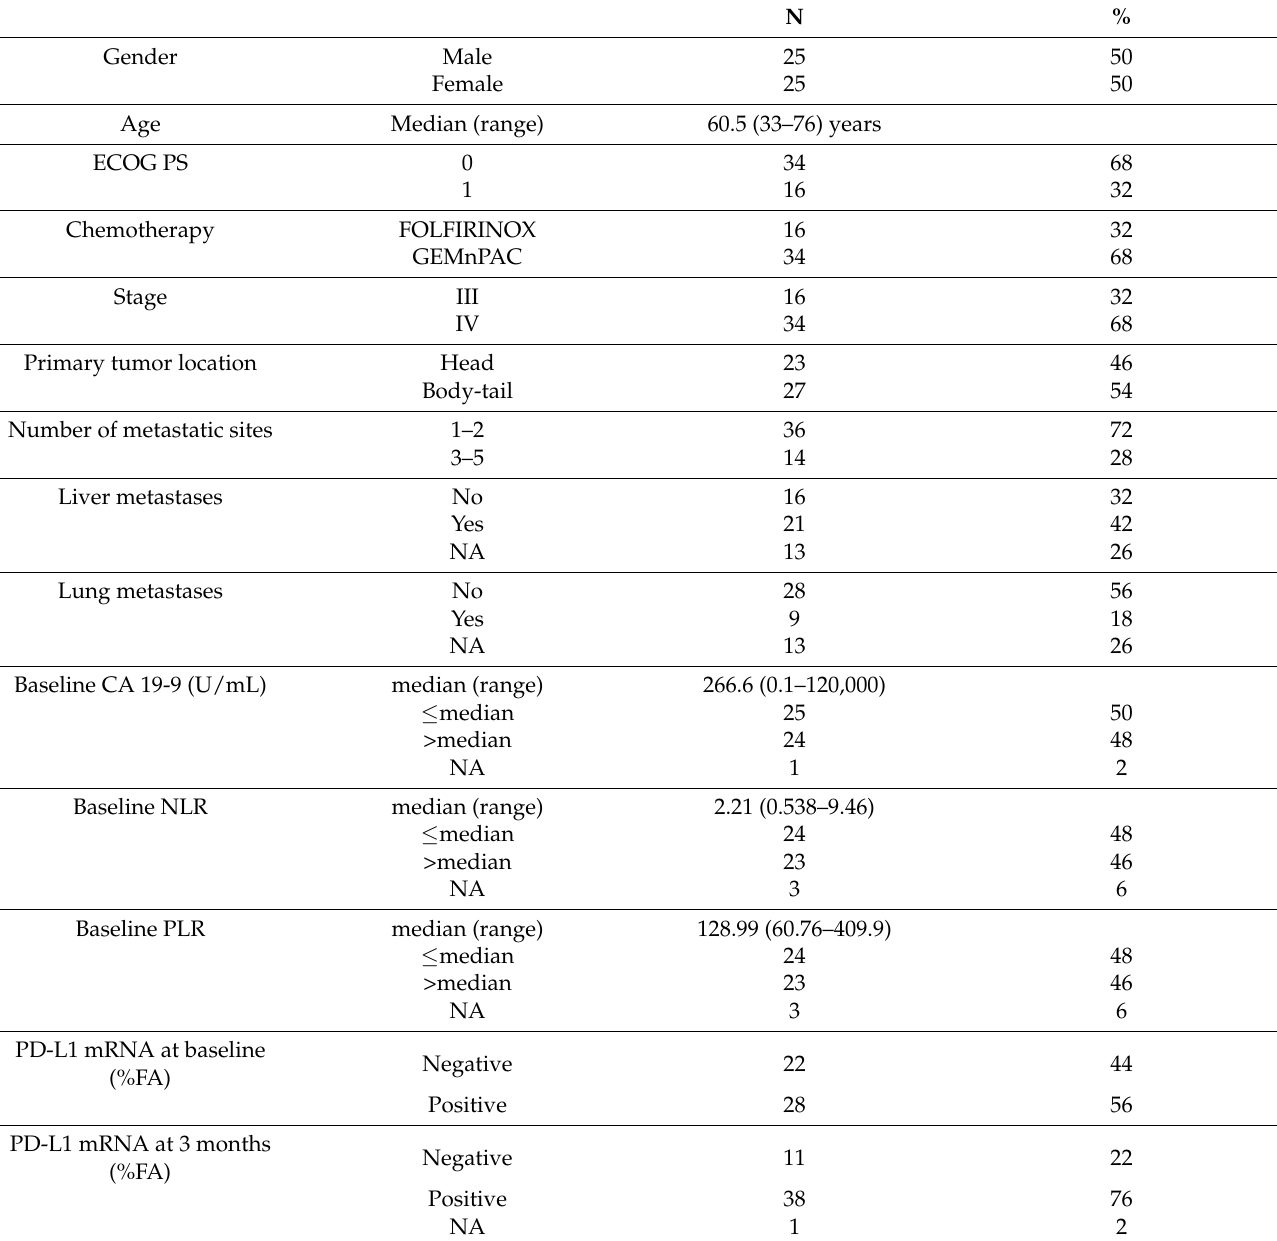
Table 1. Clinical characteristics of